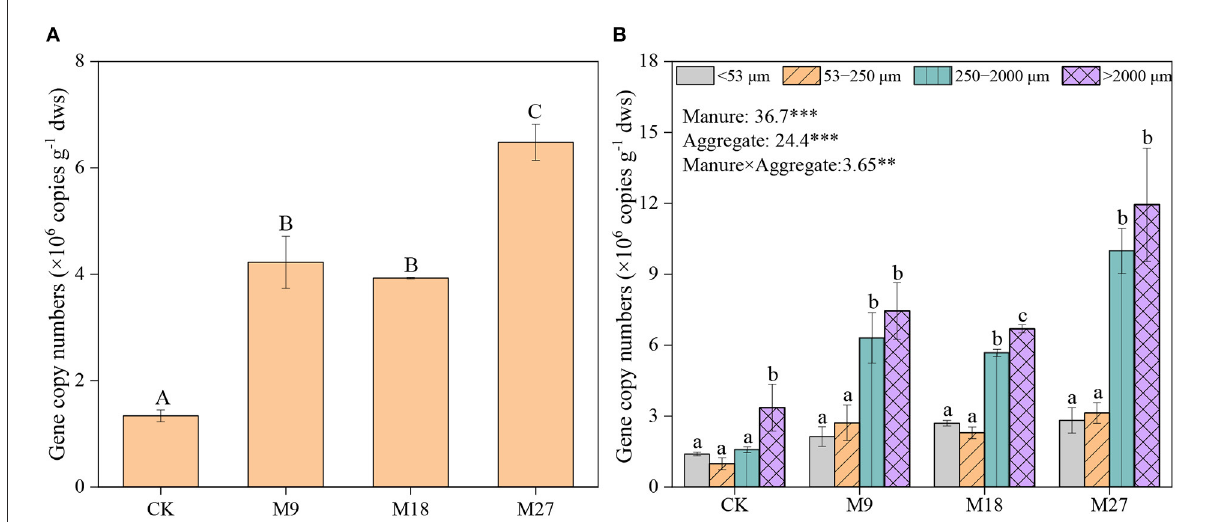
FIGURE2 Abundance of nifH gene in soils (A) and aggregates (B) following long-term manure application. Vertical bars represent standard error (n = 3). Different lowercase letters denote significant differences ( p < 0.05) between aggregate sizes in the same treatment, and different capital letters denote significant differences between different treatments. *** and ** indicate statistically significant at the 0.001 and 0.01 probability levels, respectively, while the numbers are F values by two-way